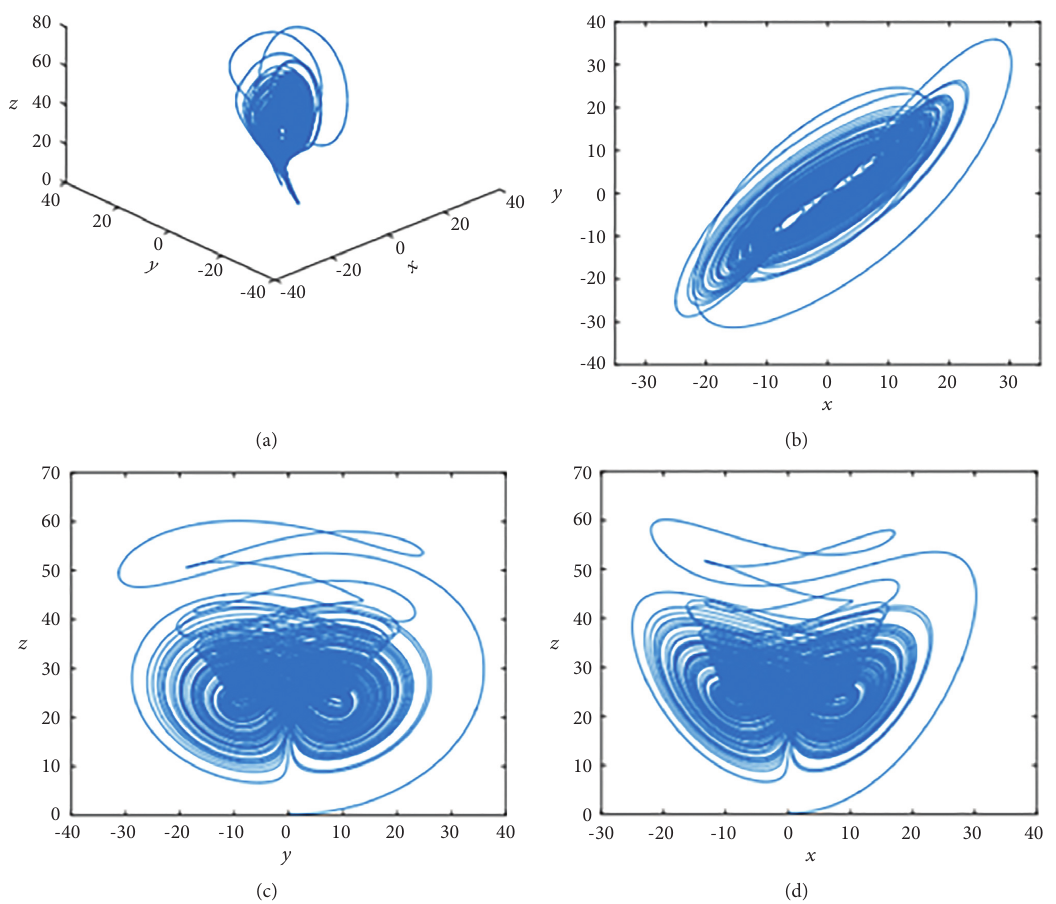
Figure 1: x − yx − z Figure 1Hyperchaos attractors of Chen’s chaotic system: (a) Distribution in the direction of x-y-z . (b) Plane graph of x- y . (c) Plane graph of y-z . (d) Plane graph of x-z .